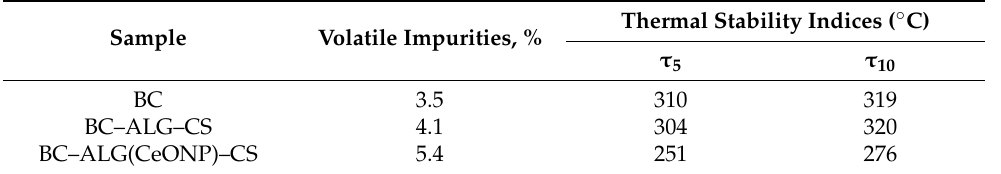
Figure 7. TGA curves of (1) BC, (2) BC–ALG–CS, and (3) BC–ALG(CeONP)–CS films. Table 3. Thermal stability indices of BC, BC–ALG–CS, and BC–ALG(CeONP)–CS films in air atmo-